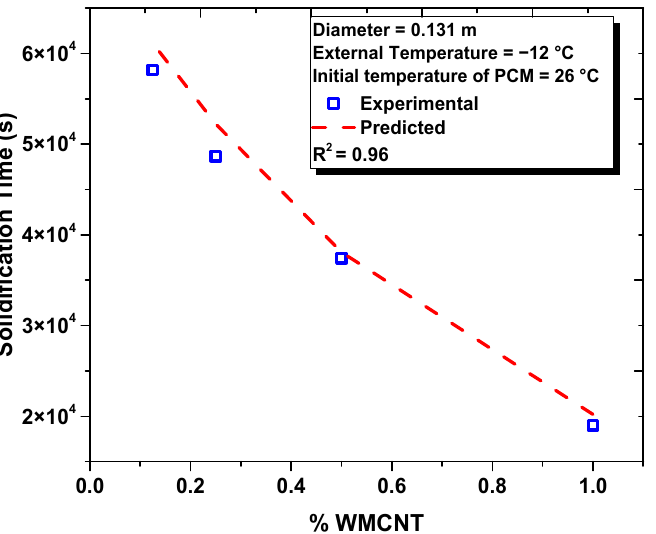
Figure 18. Comparison of the correlation of the solidification time with experimental data.